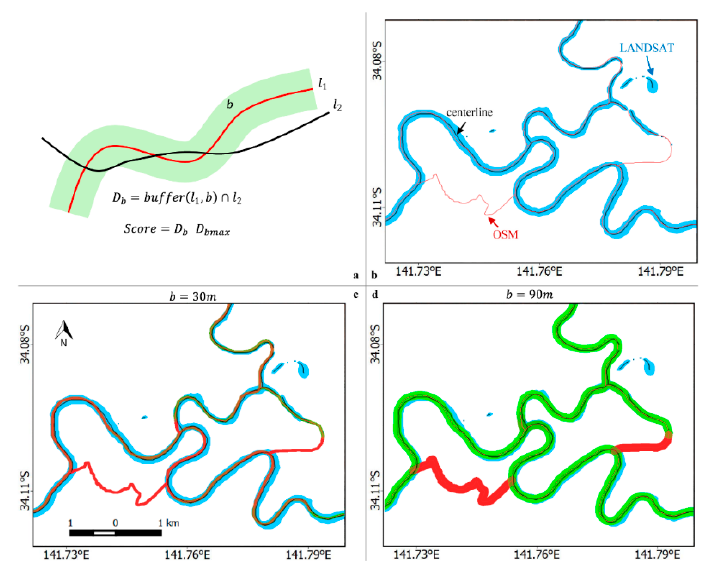
Figure 14. Method used to estimate positional differences between vector and raster datasets. Increasing overlay buffer method ( a ); example of OSM water polyline and Landsat mask ( b ); and results for two different buffer sizes ( c , d ). Remote Sens. 2016 , 8 , 386